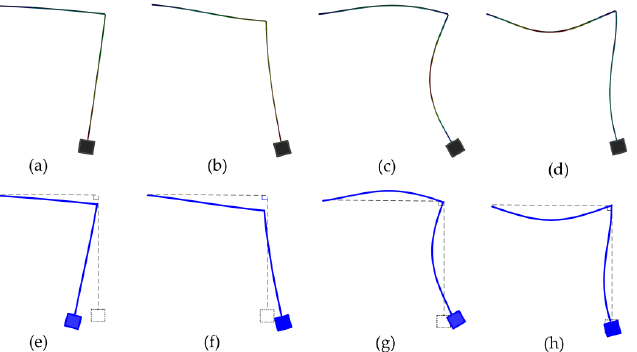
Figure 6. The 1st to 4th global mode shapes of the structure from ANSYS ( a – d ) and the presented model ( e – h ).